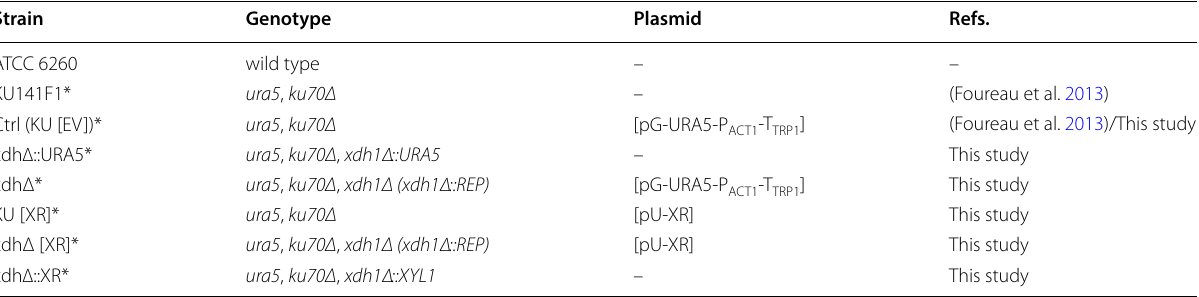
xdhΔ * KU141F1 and hence all strains derived thereof are originated from the reference strain M. guilliermondii ATCC 6260